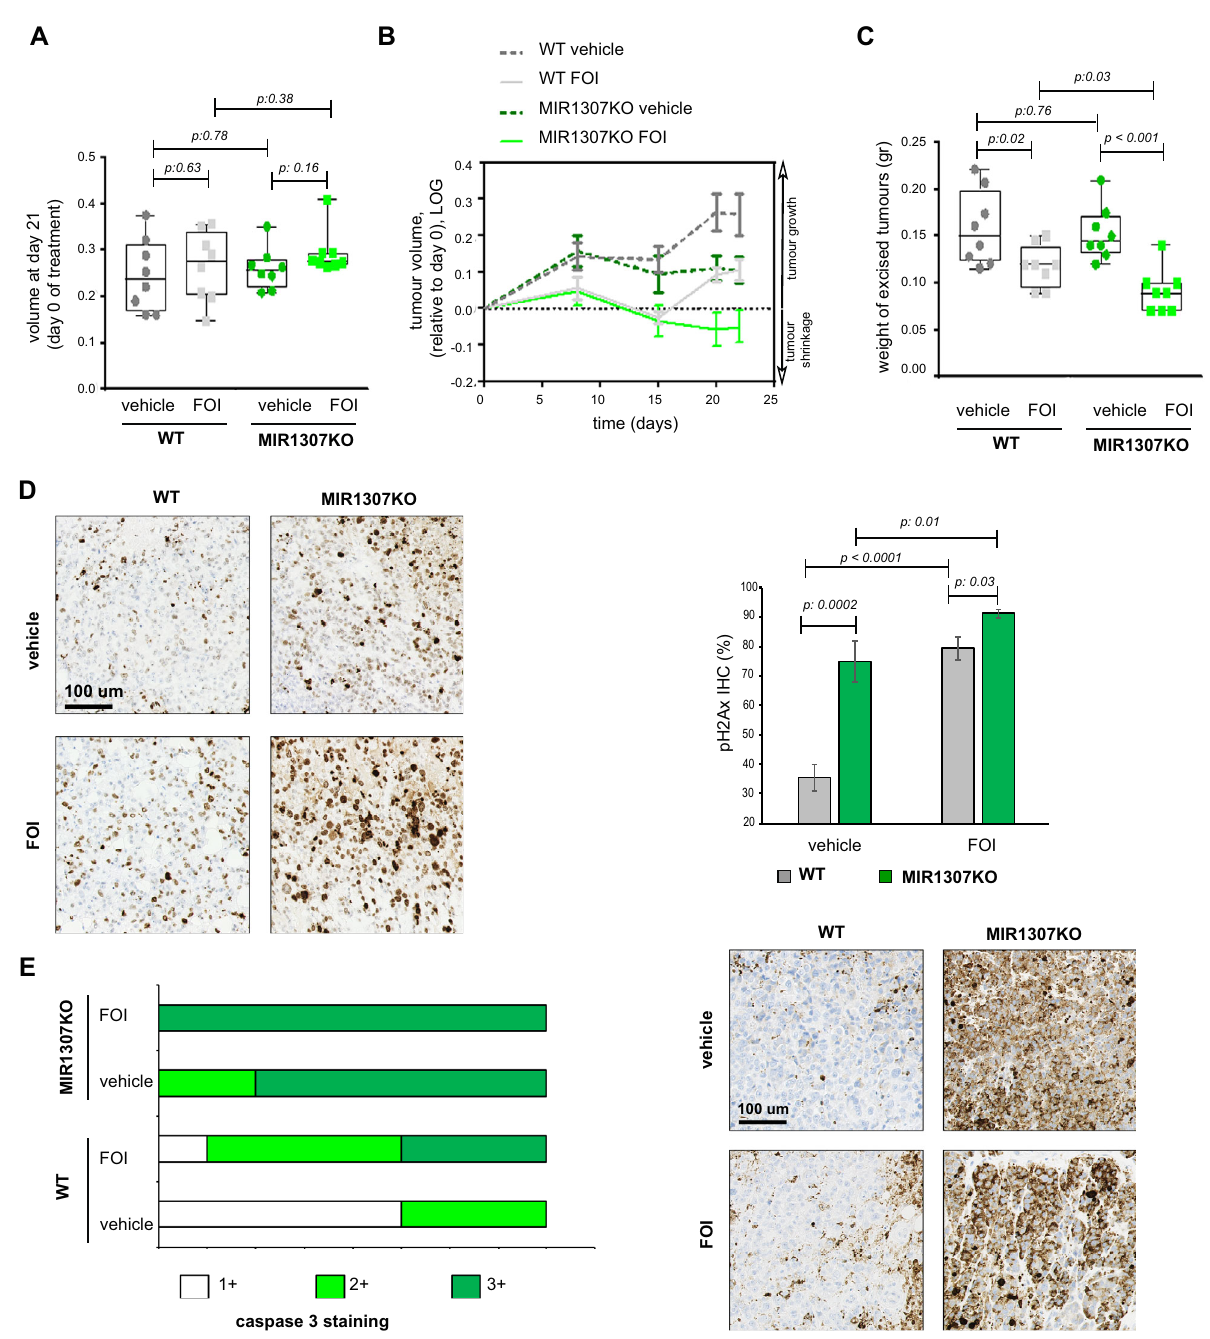
Fig. 7 MIR1307 disruption increases chemosensitivity of PDAC xenografts. WT or MIR1307KO MiaPaca2 cells were injected subcutaneously in the fl ank of NSG mice ( N = 16 each) and monitored for growth by caliper. When tumours became visible and measurable (day 21), mice were randomized to be treated with a weekly intraperitoneal vehicle (saline alone) or combination of oxaliplatin (3 mg/kg), fl uorouracil (25 mg/kg), and irinotecan (25 mg/kg) for 4 weeks before being sacri fi ced. A Tumour volume at day 21 was comparable across the groups. Minimum to maximum values are presented. The box indicates the 95% con fi dence interval with median depicted within the box. Values from two-sided t-test are reported. B Tumour volume data during treatment are shown. Data are normalized to baseline pre-treatment tumour size (day 21). For statistical data please see Table S5. Two-way ANOVA test: p 0.05. C Excised tumours were weighed before being stored at − 80 for analyses. Median values along with minimum to maximum values are shown. Values from two-sided t-test are reported. D Excised tumours were fi xed in formalin and included in paraf fi n. pH2A.X was assessed by IHC and expressed as % of positive cells in each sample. Representative picture and quanti fi cation plots are shown. Values from two-sided t-test are reported. E Caspase 3 protein expression was assessed by IHC with a semiquantitative score. Each sample was scored as mild (1 + ), moderate (2 + ), and strong (3 + ) expression. Representative picture along with quanti fi cation plots are